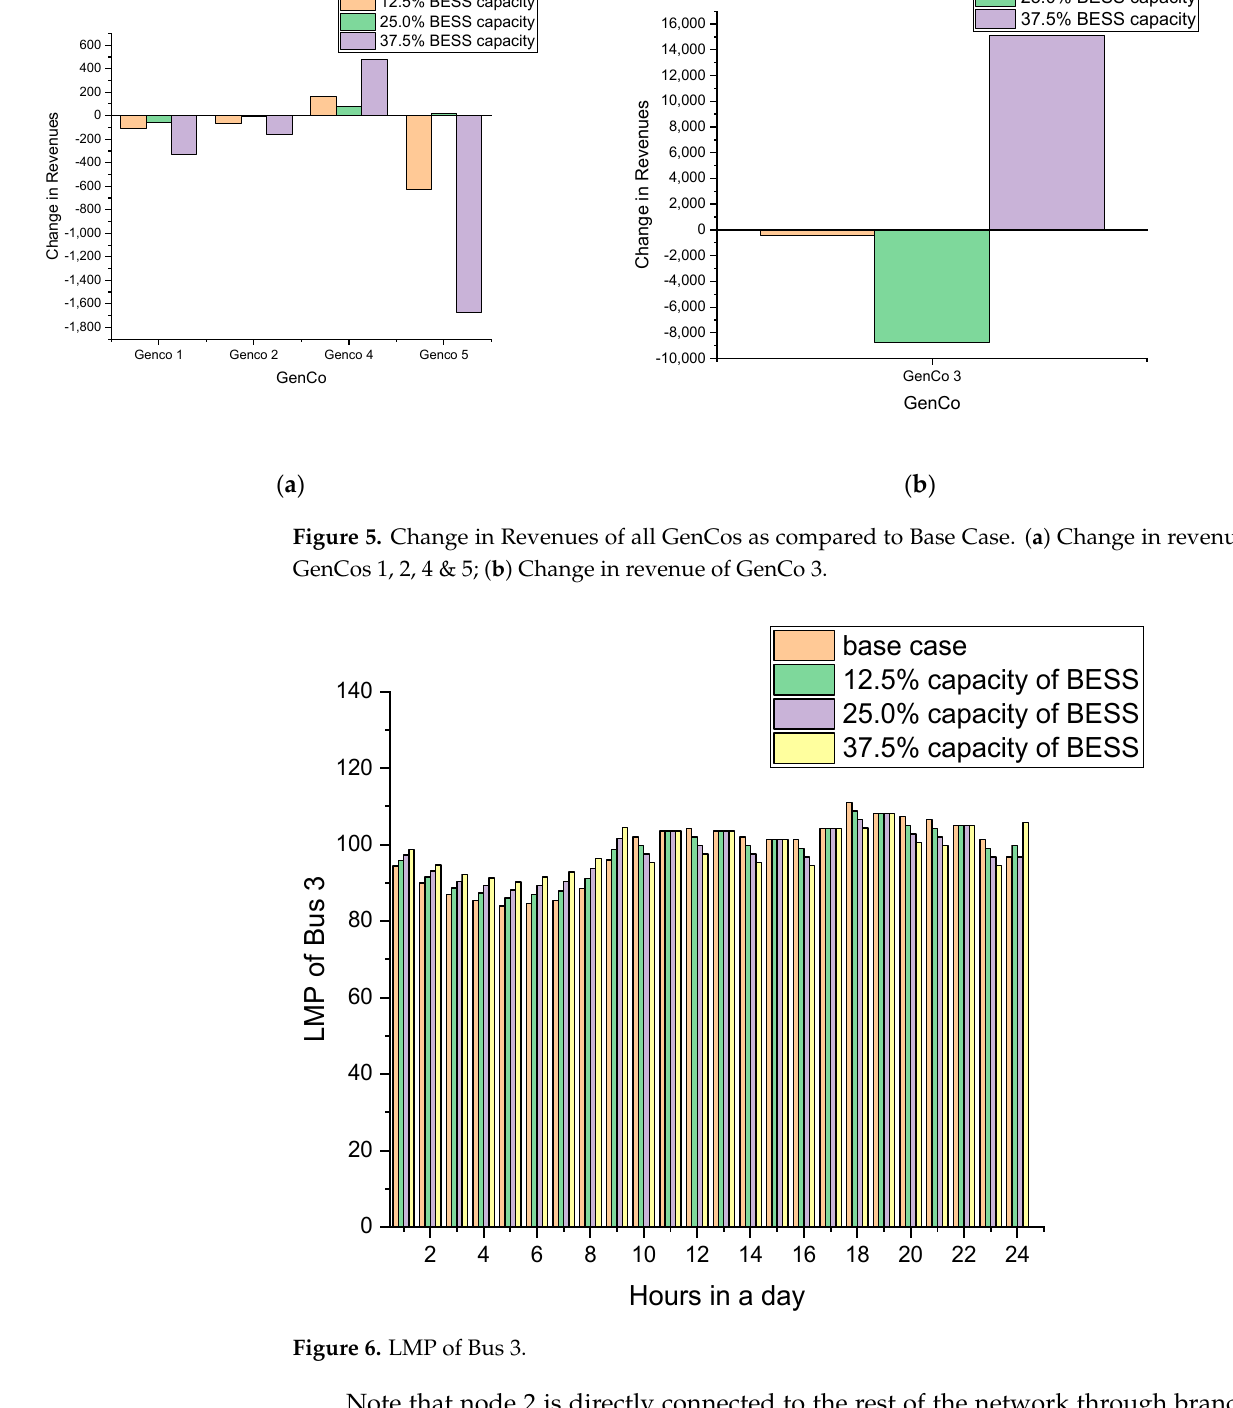
Figure 6. LMP of Bus 3.